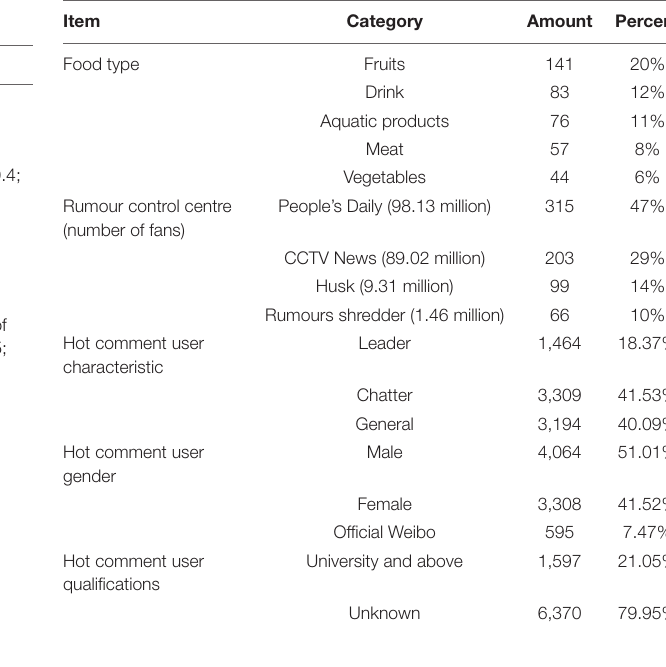
TABLE 6 | Sample feature